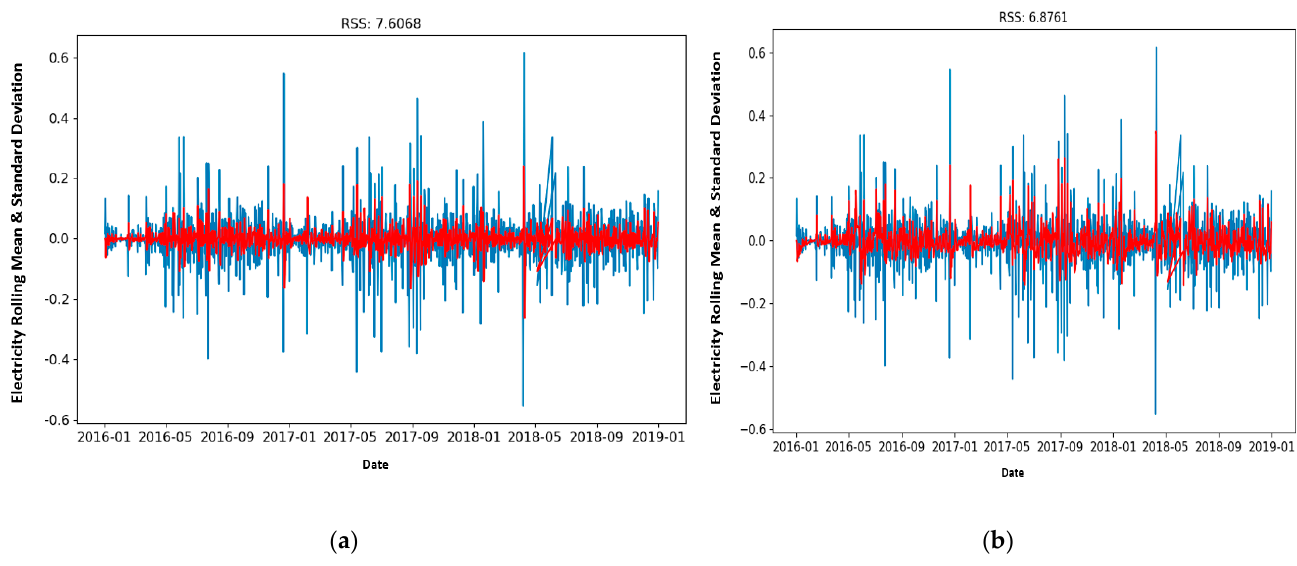
Figure 6. Test results: ( a ) autoregressive moving average RSS values for AR and ( b ) autoregressive moving average RSS values for the MA model.